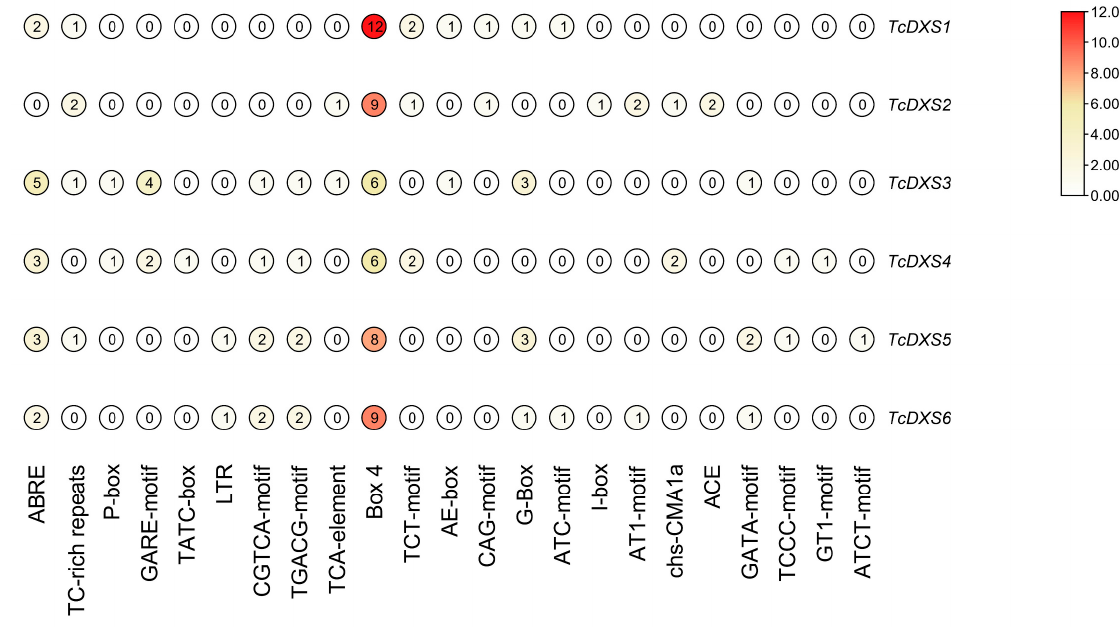
Figure 6. Numbers of each type of motif related to light responsiveness (Table S4).